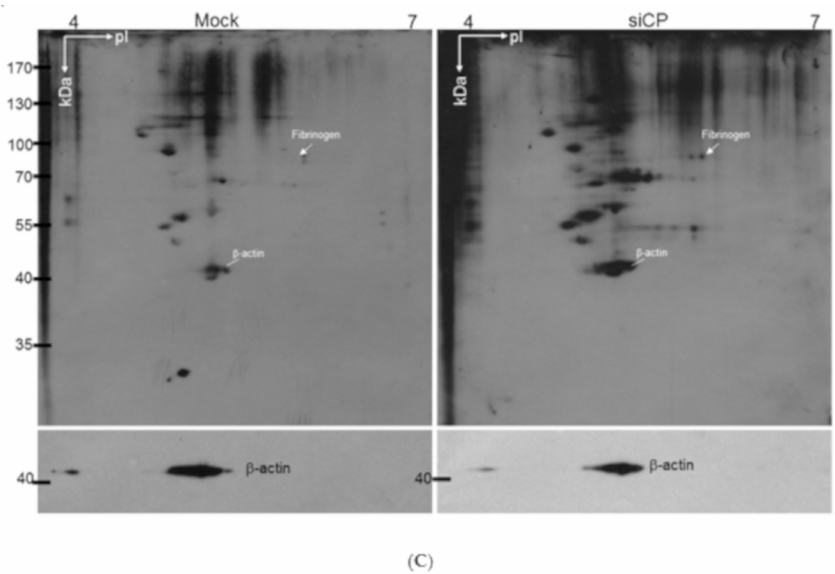
Figure 4. ( A ) E ff ects of exogenous copper upon changes in the fibrinogen expression of HepG2 cells. After HepG2 cells had been treated with 0.5 and 100 µ M copper, the intracellular localizations and level of fibrinogen (green) and nucleus (red) were examined by immunofluorescence microscopy. ( B ) Silence of ceruloplasmin (siCp) treatment induced the protein expression of fibrinogen, while the significant reduction in protein level for SOD was observed under siCp applications. β -actin was used as a loading control. Quantification of the result was presented as the bar diagram and the results represent the mean ± SD of three independent experiments (*** p < 0.0001; ** p < 0.001). ( C ) Levels of protein carbonylation. Significantly increased expression of carbonylated proteins were observed in the ceruloplasmin-silenced group (siCp) compared to the control (Mock). β -actin performed by Western blot analysis was utilized as the loading control and the individual carbonylated proteins separated by 2-DE analysis then could be normalized to the intensity of the β -actin protein for determining the protein oxidation